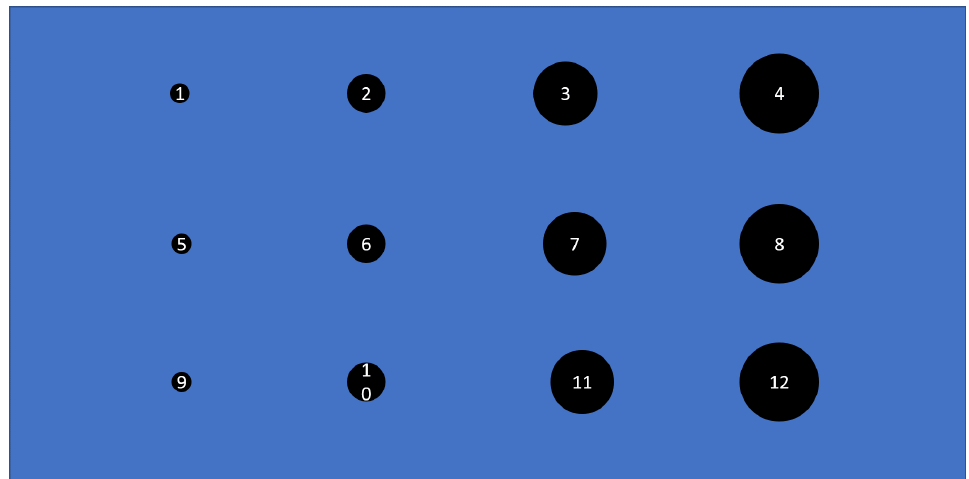
Figure 8. Visual representation of the PVC flat bottom hole plate with various depths and diameters. Holes 1–4 have a depth of 2.5 mm, 5–8 have a depth of 5.5 mm and 9–12 a depth of 8.5 mm. Every vertical set of holes have a different diameter starting with 6 mm for holes 1, 5 and 9. The distance between the centre of the holes is 45 mm in order to minimise the influence of one defect on another. The parameter set is optimised for hole 2 and resulted in following combination: d heat − cam = 50 mm, P heat = 16.7 W/cm 2 , v source = 5 mm/s, d height = 300 mm, T ambient = 22 ◦ C, d start = 2.5 mm, D hole = 12 mm and Maximum use temperature of 80 ◦ C. Optimising